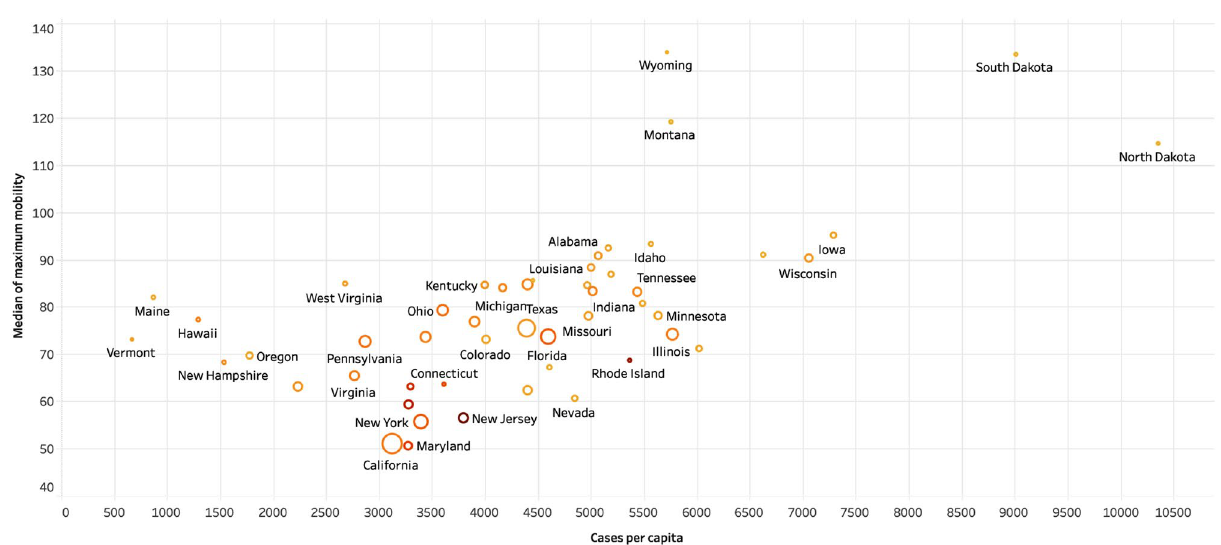
Figure 5. Impact of number of weeks mask mandate was active and the mobility on the number of cases per